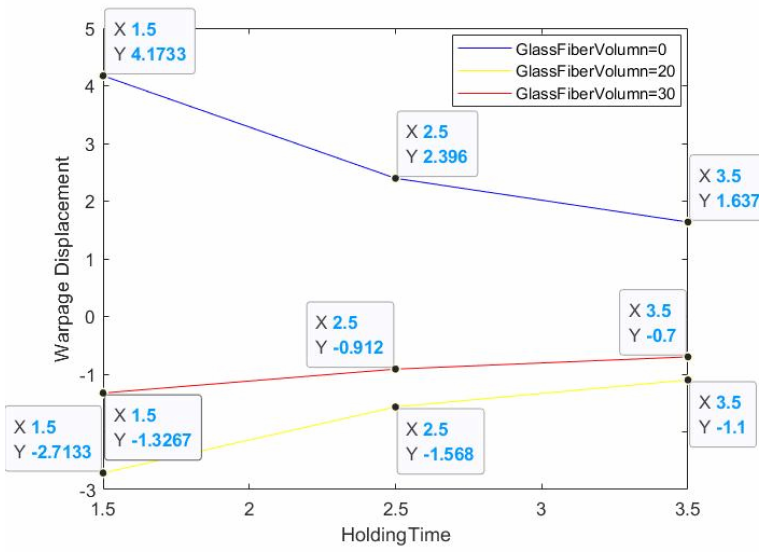
Figure 4. Warpage displacement with glass fiber and